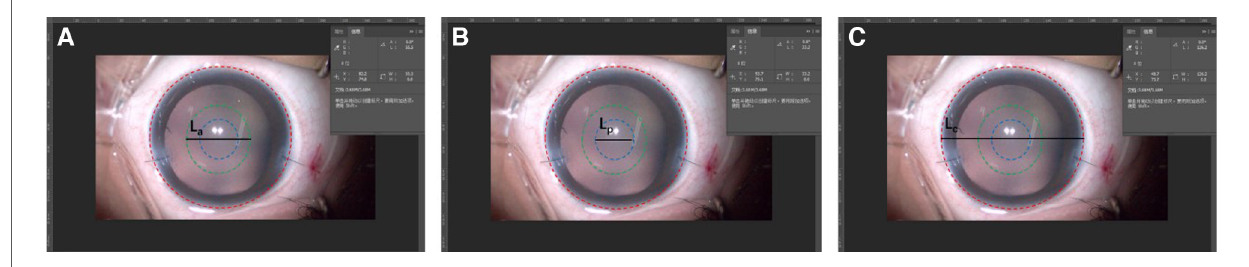
FIGURE 1 Measurements of anterior capsulotomy opening diameter (ACOD) and posterior capsulotomy opening diameter (PCOD) using adobe photoshop CC 2018. The red, green, and blue circles represented the cornea and, anterior and posterior capsulorhexis opening, while La, Lp, and Lc represent ACOD, PCOD and corneal diameter (CD), respectively, in units of pixels. As the value of CD (mm) was measured, the values of ACOD and PCOD (mm) could be calculated by equal-scale conversion: ACOD ¼ CD (cid:2) La = Lc ; PCOD ¼ CD (cid:2) Lp = Lc .